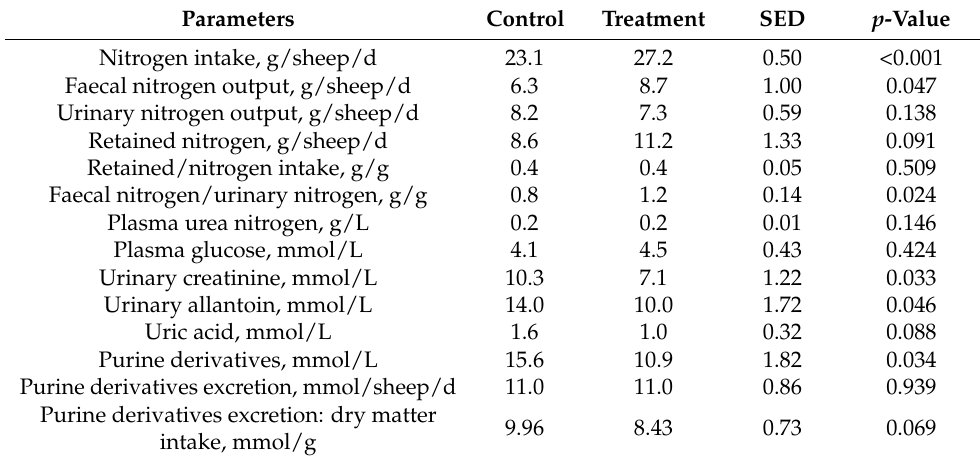
Table 4. Effects of feeding a diet containing 20% grape marc on predicted nitrogen balance, plasma metabolites, and urinary purine derivatives of merino sheep. Parameters